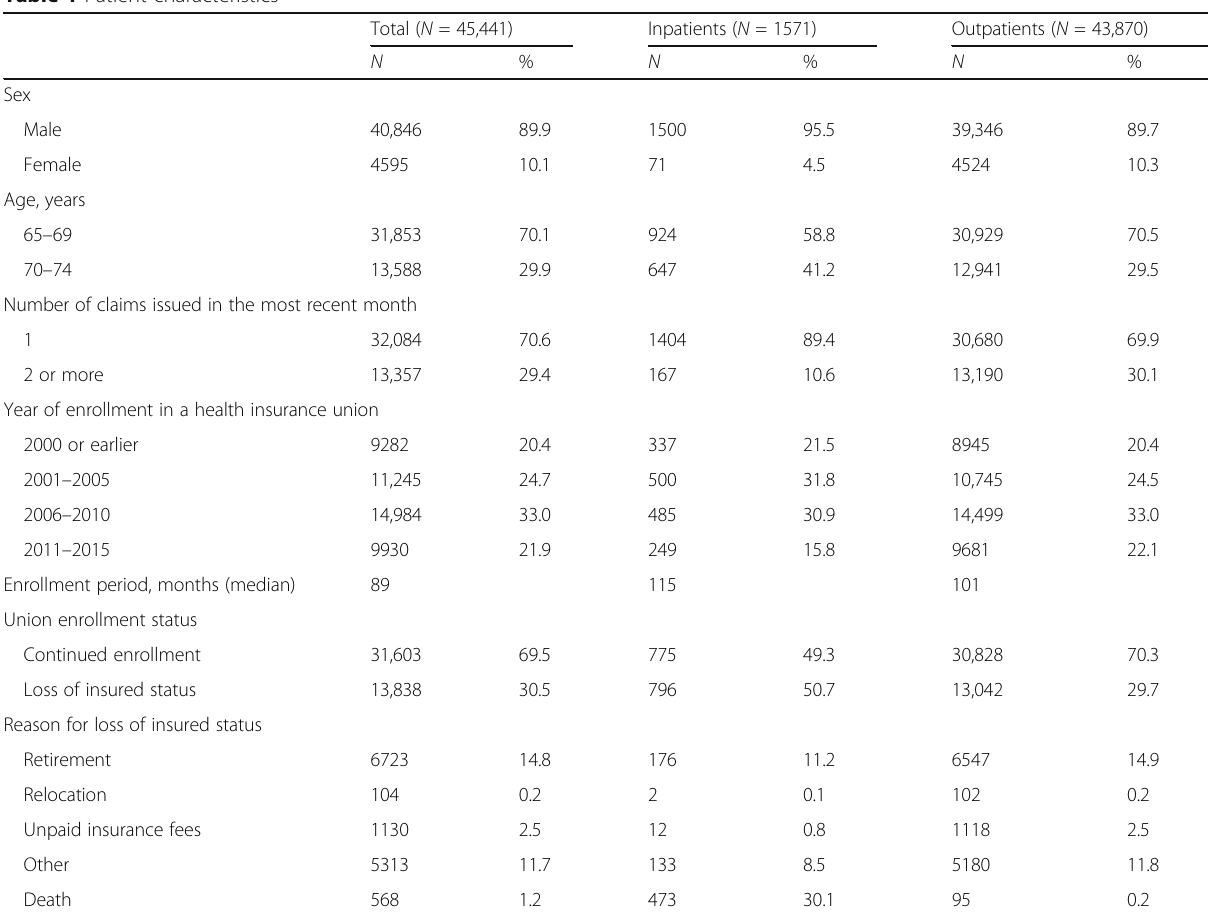
Table 1 Patient characteristics